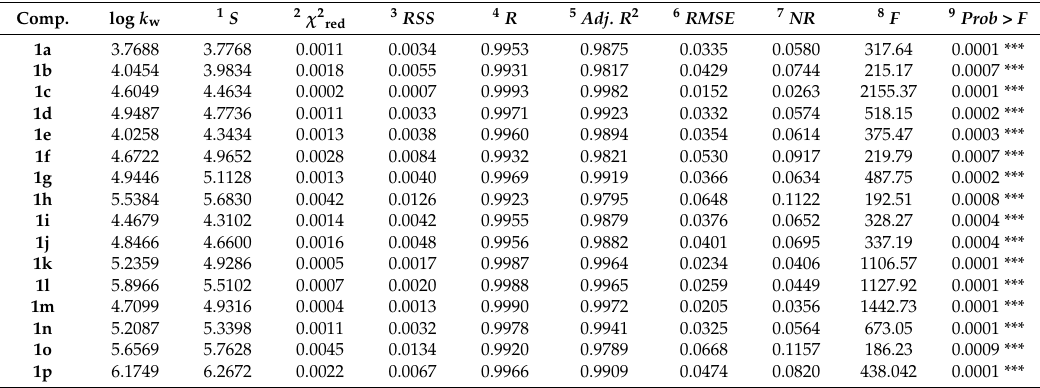
Table 3. Extrapolated log k w parameters (RP-HPLC) of analyzed molecules 1a – p and values of